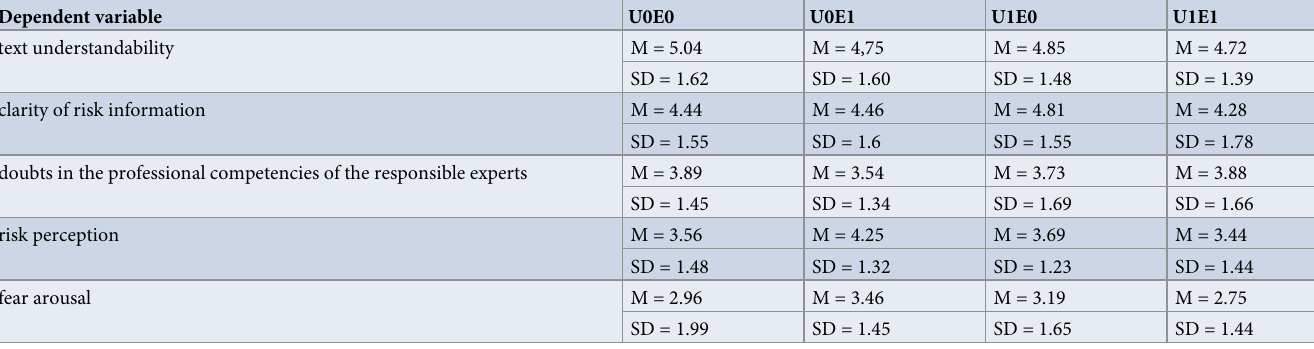
Table 4. Effects of uncertainty description about risk characterization